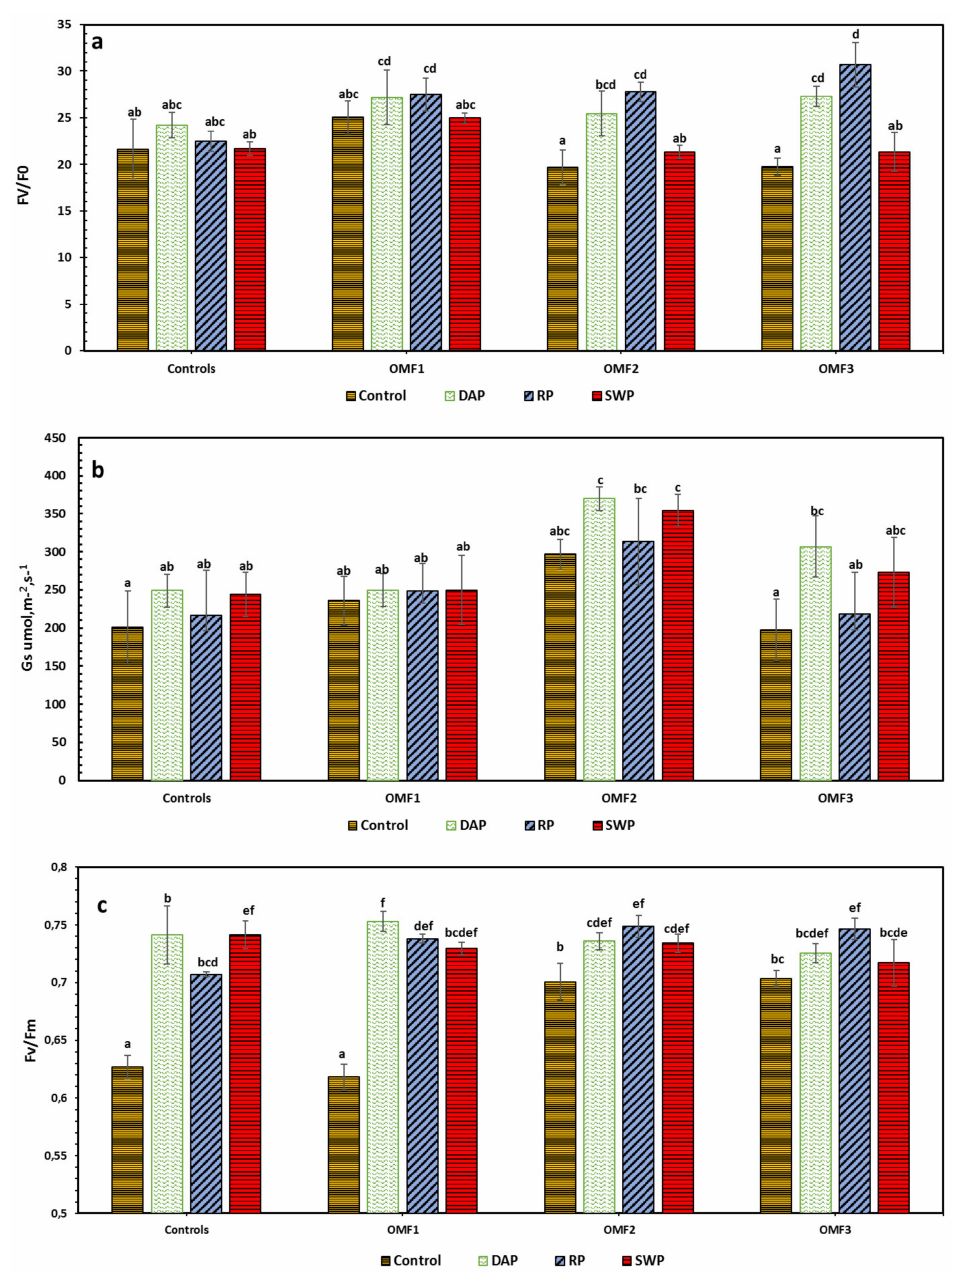
Figure 4. Effect of OMF formulations on plant agro-physiology parameters; ( a ) the potential pho- tosynthetic activity (Fv/F0), ( b ) Stomatal conductance gu umol m − 2 . s − 1 , ( c ) maximum quantum efficiency of PWSII (Fv/Fm). Results represent the means ( ± standard deviation) of five replicates. Different letters are significantly different according to Tukey’s test at p <